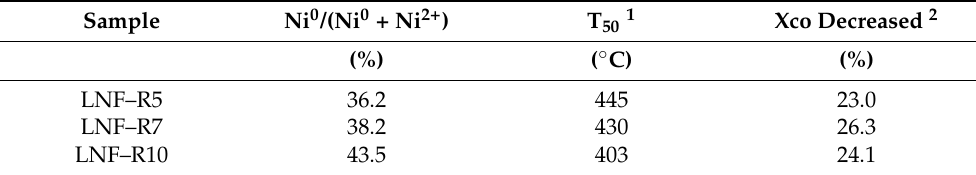
Table 2. Catalytic activity and stability of the reduction treated LNF